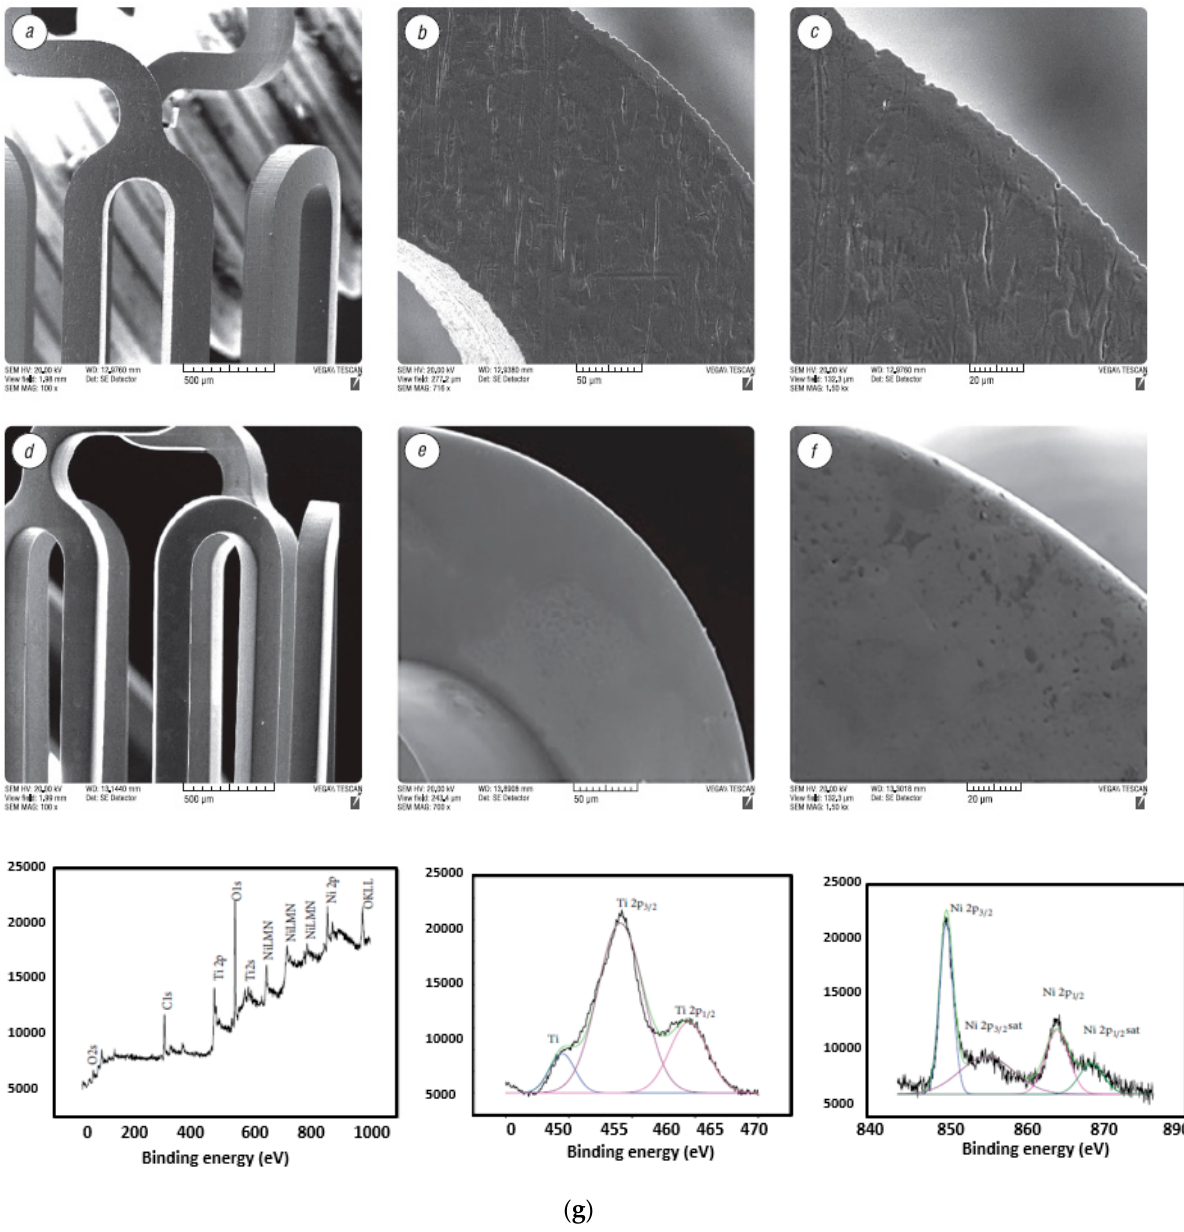
Figure 24. Micro-photographs of stents before ( a – c ) and after ( d – f ) EP showing scratches, oxide and slag [56]; ( g ) XPS analysis of mechanically polished Nitinol implant [162] (open access article distributed under the Creative Commons Attribution